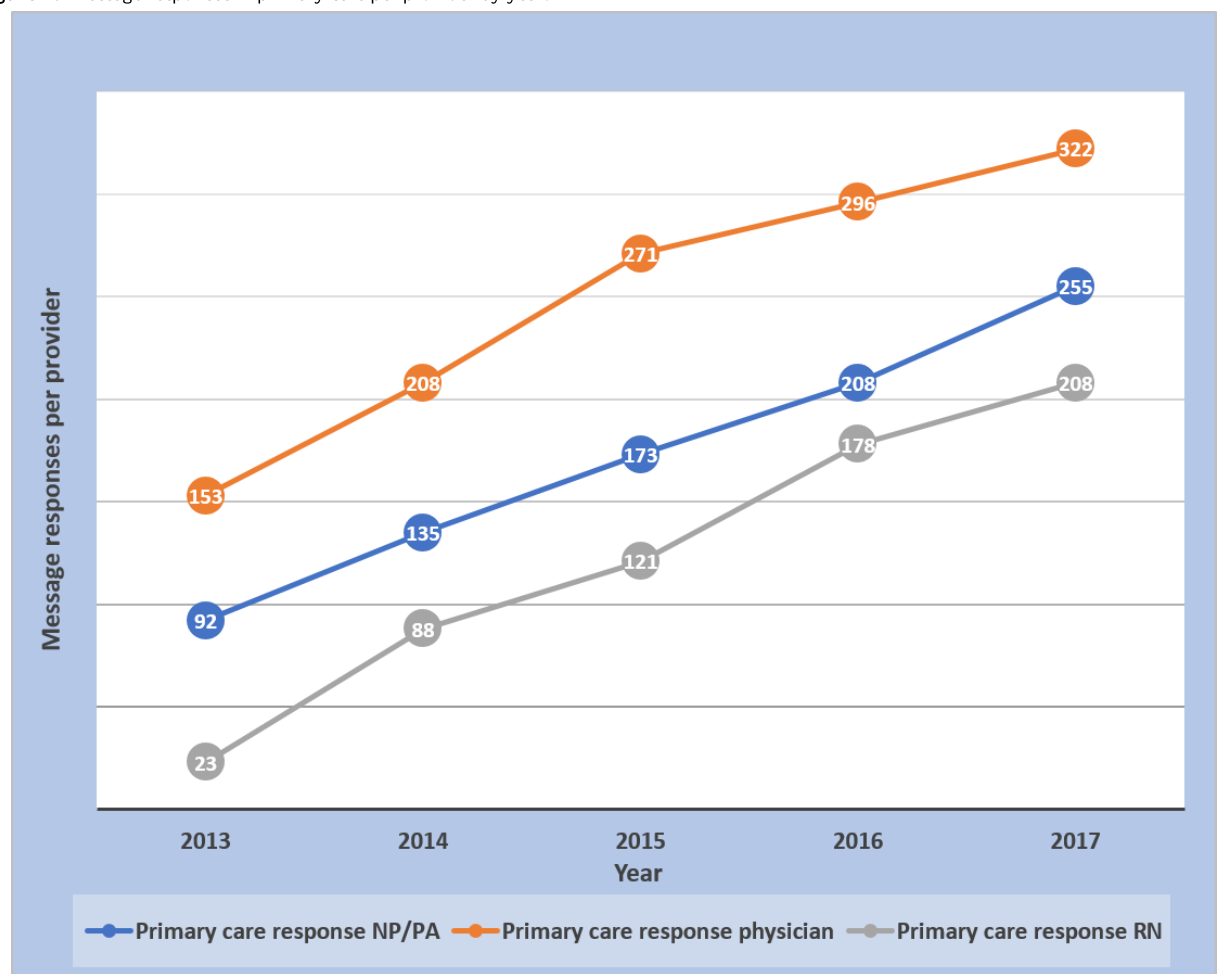
Figure 4. Message responses in primary care per provider by